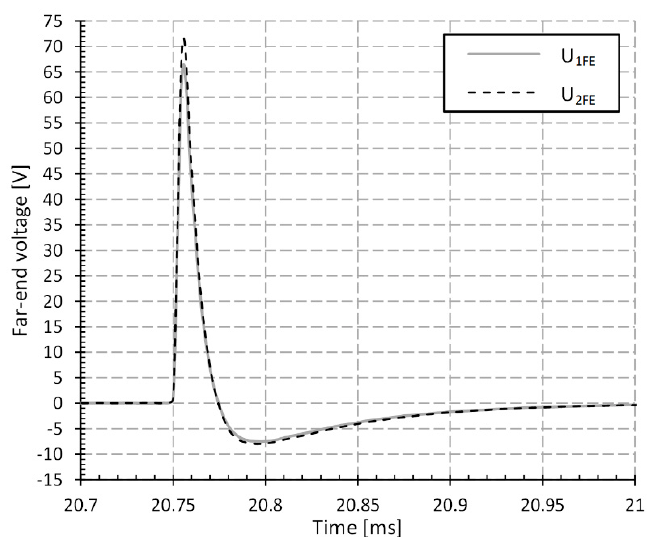
Figure 11. The comparison of measured voltages of wire 1 and 2 at far-end for case A.